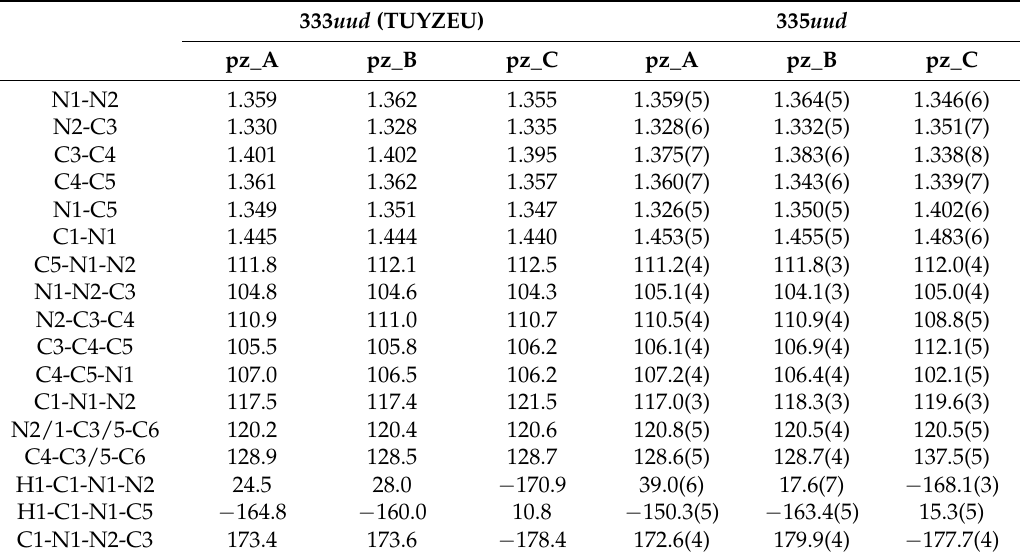
Table 4. Selected geometrical parameters for 333 and